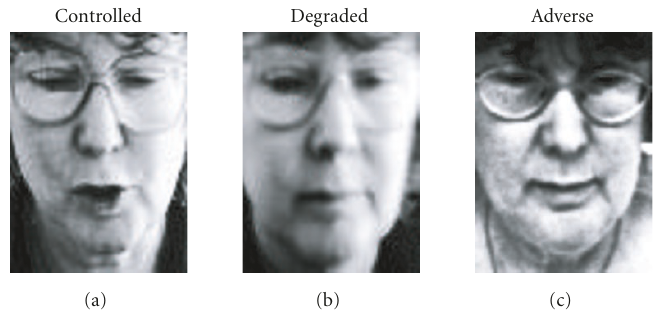
Figure 3: Example of the images collected in the controlled, degraded, and adverse scenarios (left to right) from the same